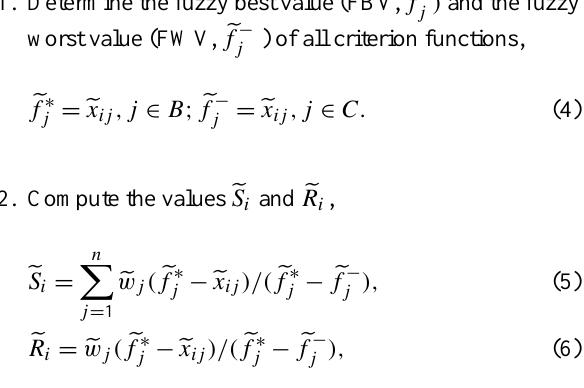
Economic factors